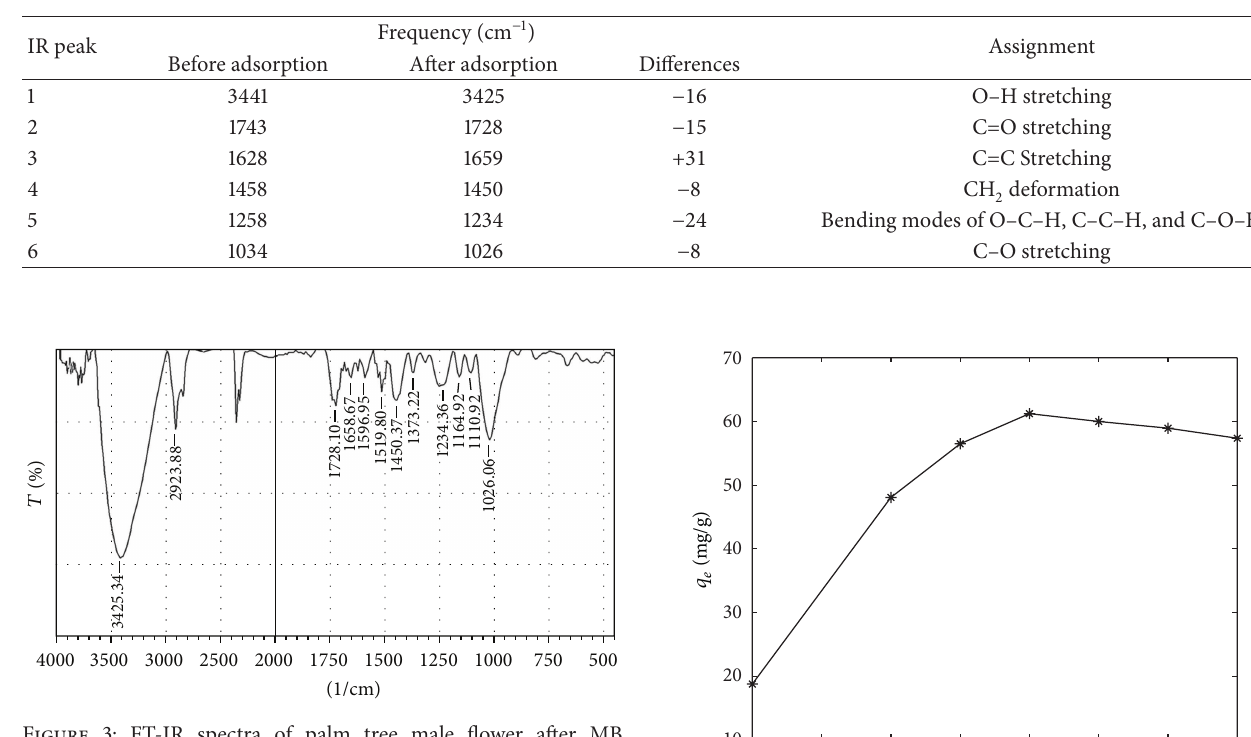
Table 1: The FTIR spectral kinetics characteristics of PTMF before and after adsorption.